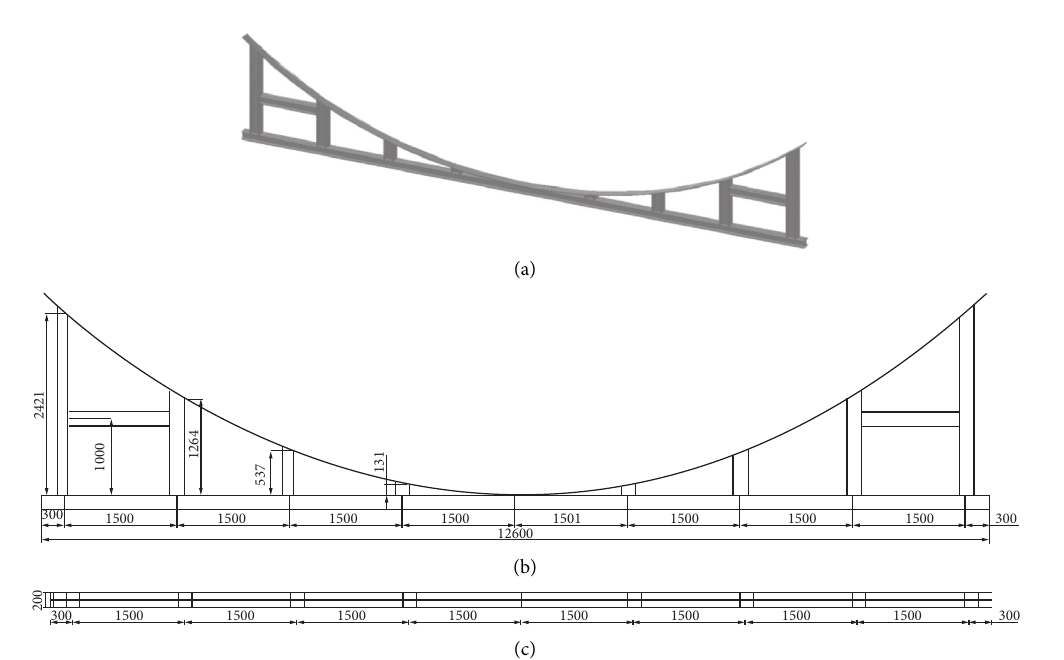
Figure 14: Assembly jig B: (a) 3D model; (b) side view; (c) top